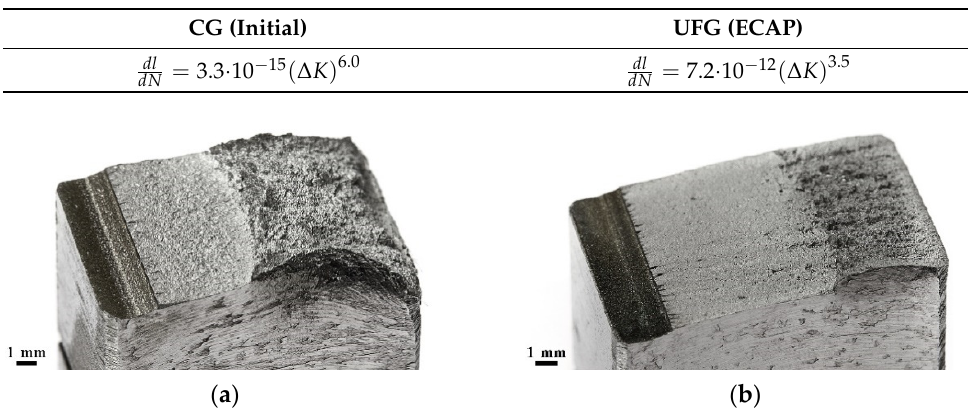
Figure 8. General view of the fatigue fractures of the specimens from the CG ( а ) and UFG ( b )